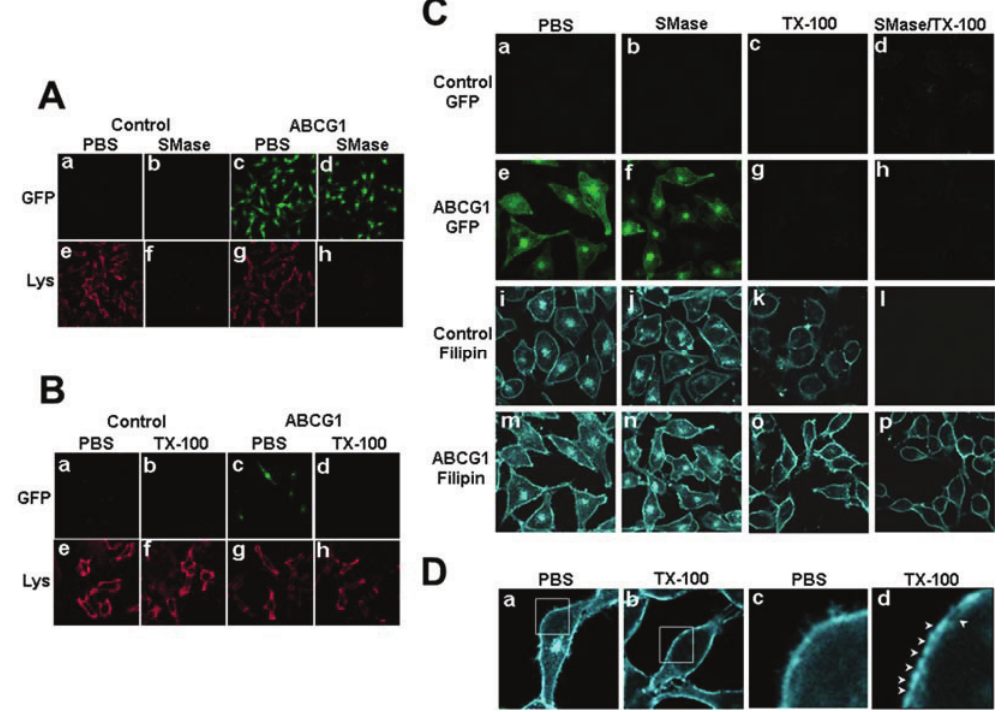
Figure 2. ABCG1-GFP alters cholesterol detergent solubility. ( A ) Control and ABCG1 cells were incubated with PBS or SMase, washed, fixed and immunostained with lysenin as described in “Experimental Section”. ( B ) Control and ABCG1 cells were incubated with cold PBS or 1% TX-100 detergent for 30 min, washed, fixed and immunostained with lysenin as described in “Experimental Section”. ( C ) Control and ABCG1 cells pre-treated with or without SMase, were extracted with 1% TX-100 on ice for 30 min, fixed, filipin stained, and imaged by confocal microscopy as described in “Experimental Section.” ( D ) Higher magnification of filipin-stained AGCG1 cells clearly reveals that LE FC (a) is removed by TX-100 (b). Enlargements of the boxed regions in (a) and (b), shown in (c) and (d), respectively, reveal that TX-100 treatment depleted FC from PM domains ( arrowheads